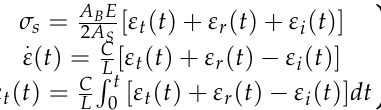
Figure 1. SPHB experimental device.